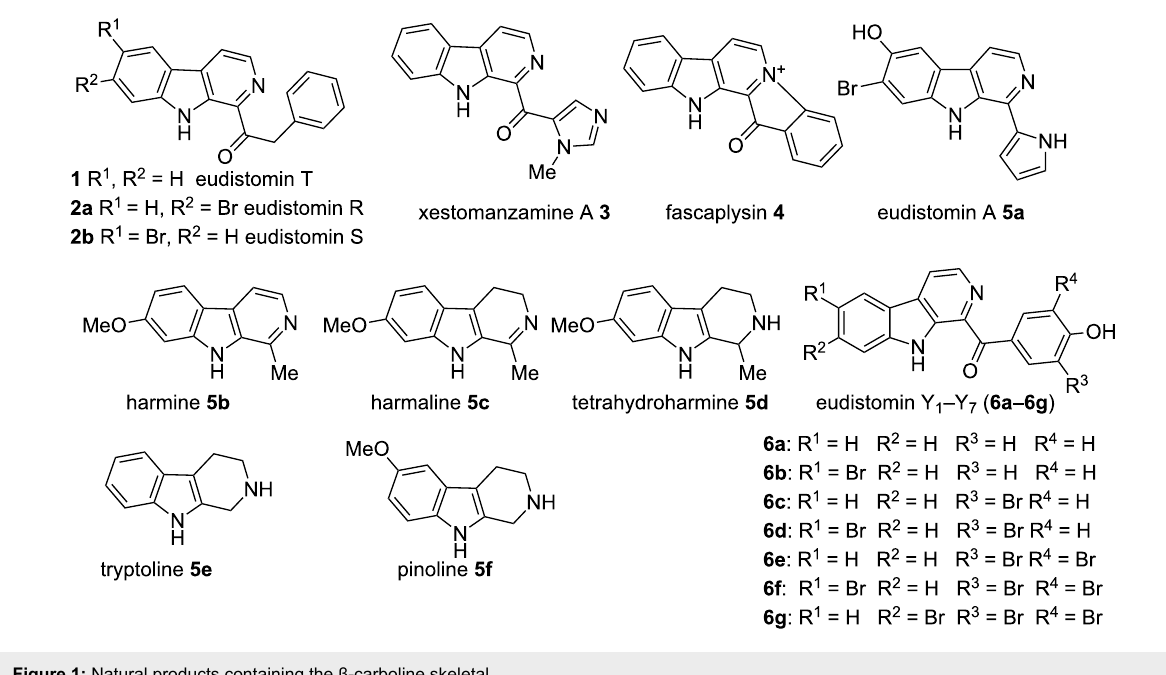
Figure 1: Natural products containing the β -carboline skeletal.